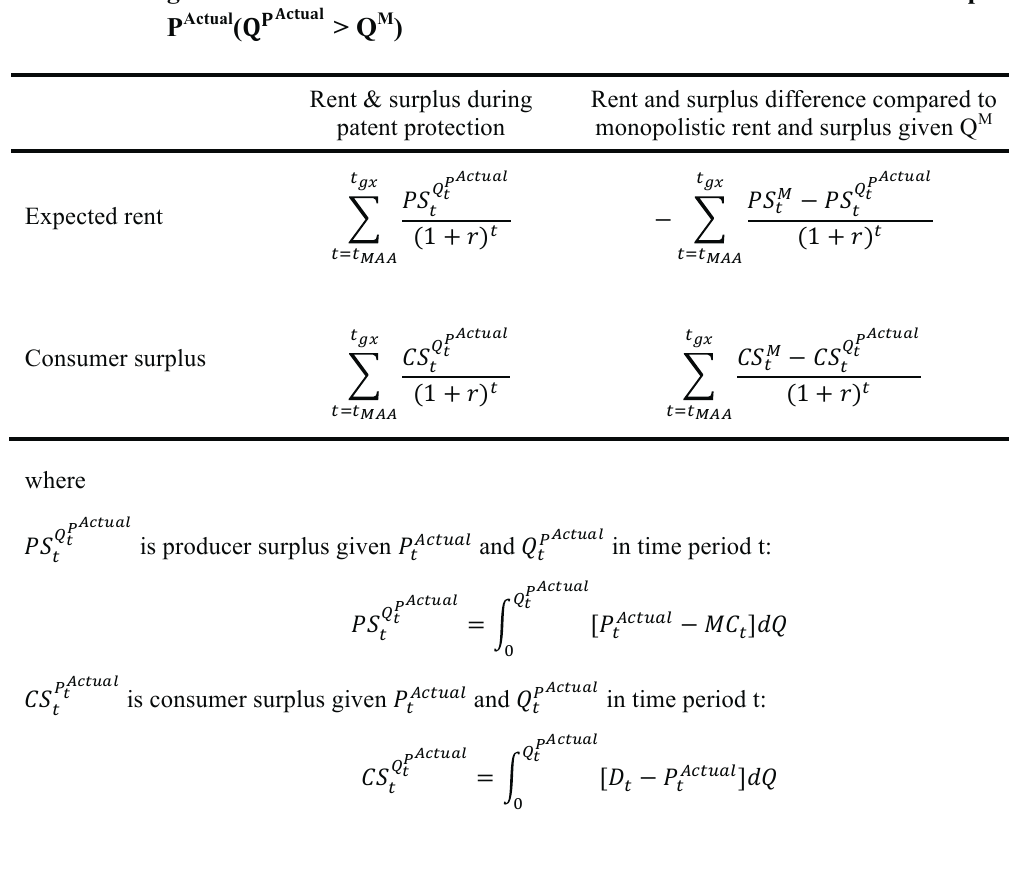
Table A3: Expected rent and consumer surplus during the time of patent protection given the use of IRP or PT and increased utilisation at price